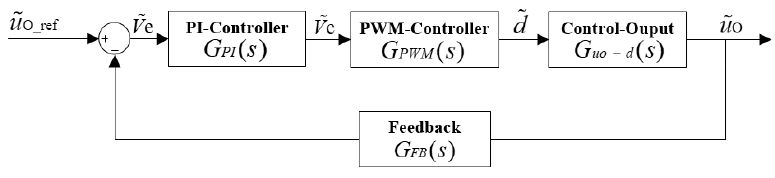
Figure 4. Block diagram of feedback control system.